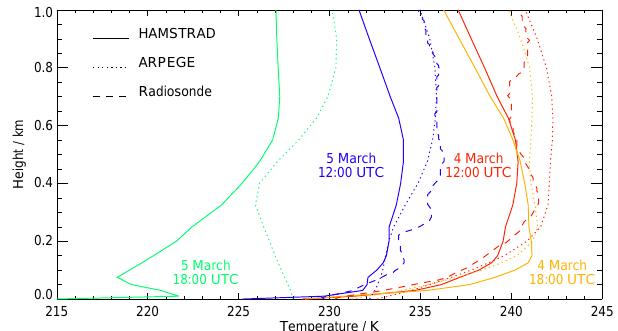
Figure 13. Vertical distribution of temperature measured by HAM- STRAD (solid line) and radiosondes (dashed lines) and calculated by ARPEGE (dotted lines) on 4 March 12:00UTC (red line) and 18:00UTC (orange line) and on 5 March 12:00UTC (blue line) and 18:00UTC (green line). Note radiosondes are only available at